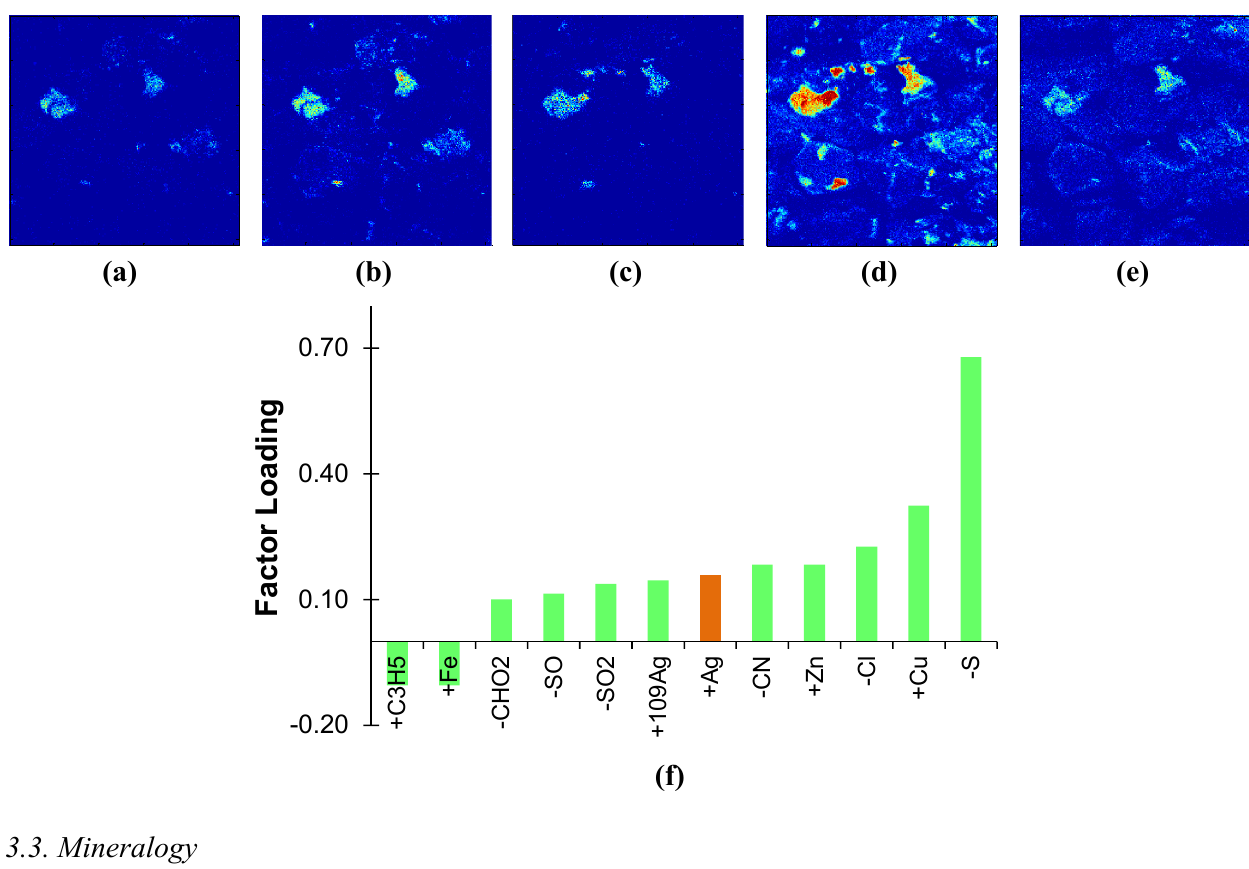
Figure 7. ToF-SIMS image (250 × 250 μ m) of ( a ) Ag; ( b ) Cu; ( c ) Zn; ( d ) S; and ( e ) CN. ( f ) Graph of factor loadings for Principal Component 2 for this area of ToF-SIMS data showing clear statistical correlation of Ag to CN, as well as Cu, Zn and S, suggesting flotation depression of these value